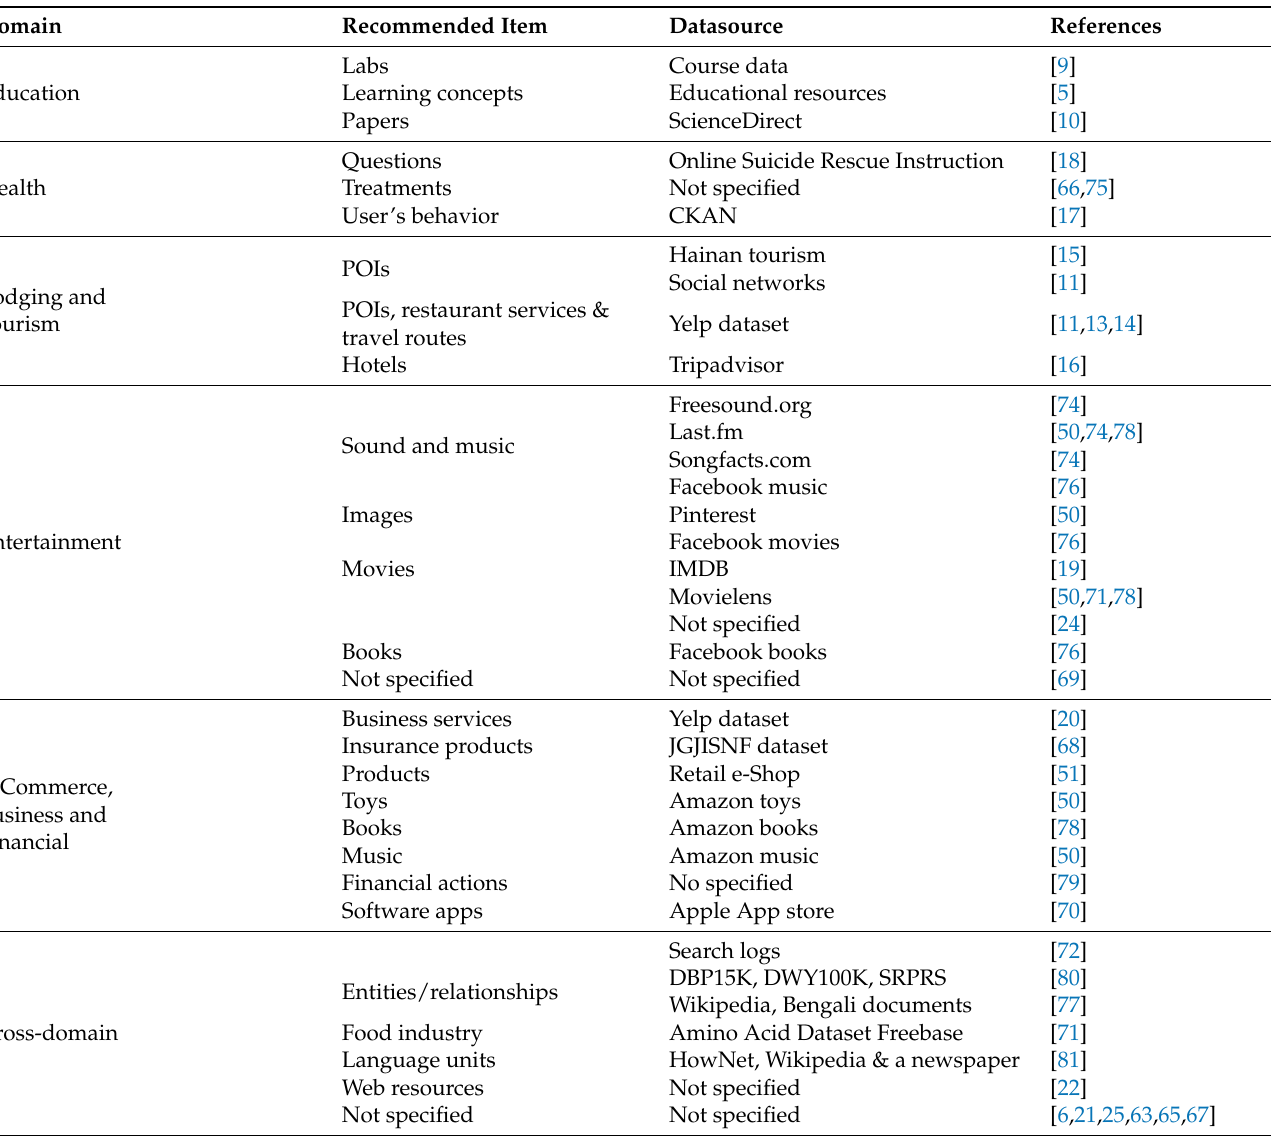
Table 3. Data sources used by